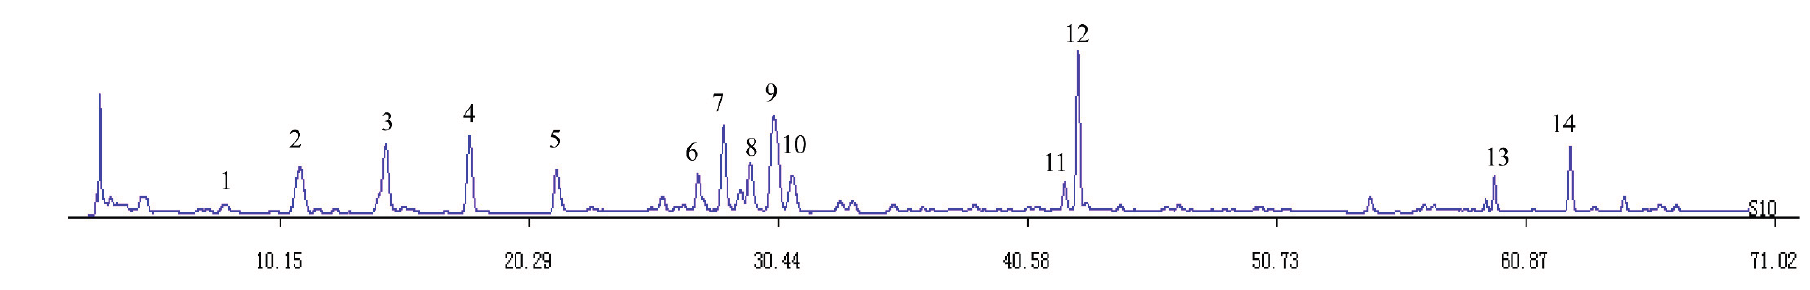
Figure 1. The HPLC fingerprints of the extracts of various chicory and reference standard fingerprint from the 10 chromatograms.